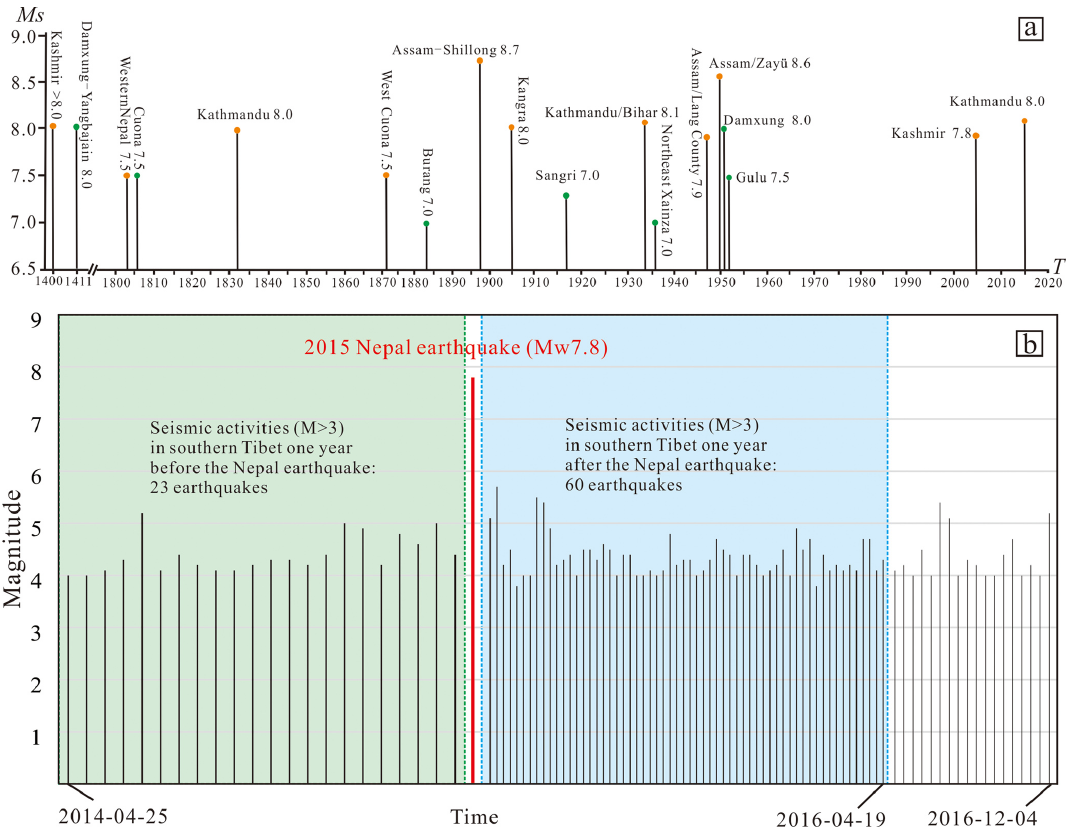
Figure 9. (a) Magnitude–time ( M s – T ) distribution of historical seismic activity along Himalaya and southern Tibet with the magnitude > 7 . 0. The orange circles show the earthquakes that occurred along Himalaya, while the green circles show the earthquakes along the southern Tibetan rift. (b) Magnitude–time ( M – T ) distribution of seismic activity in southern Tibet in the period of 1 year before and after the 2015 Nepal earthquake (data are from